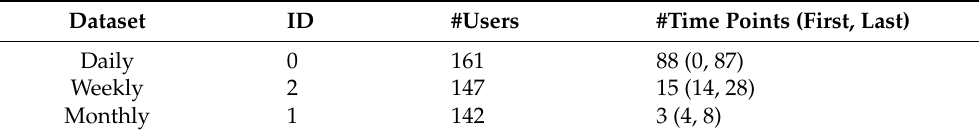
Table 1. Selected coclusters for each of the scaled datasets at InfraQuinta, 2017.